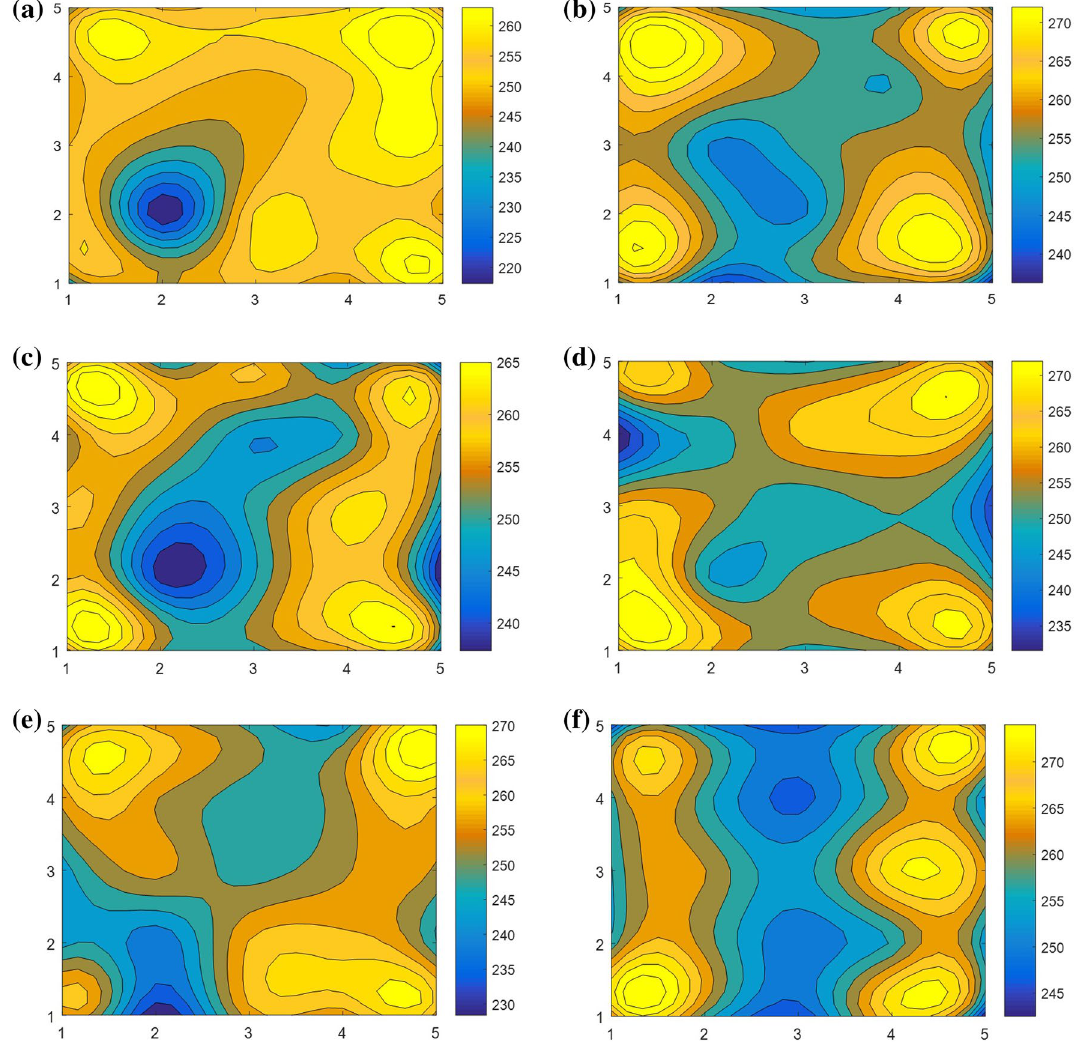
Figure 14. Hardness cloud diagram of samples under different scanning strategies: ( a , b ) Island scanning; ( c , d ) helix scanning; ( e , f ) slope subarea scanning; ( a , c , e ) HD; ( b , d , f ) BD.